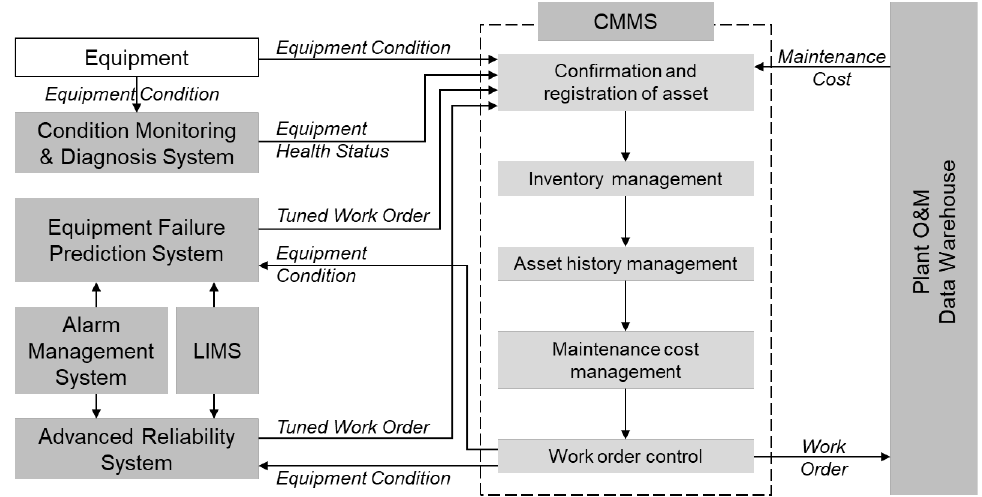
Figure 3. Maintenance systems and data exchanged between them.